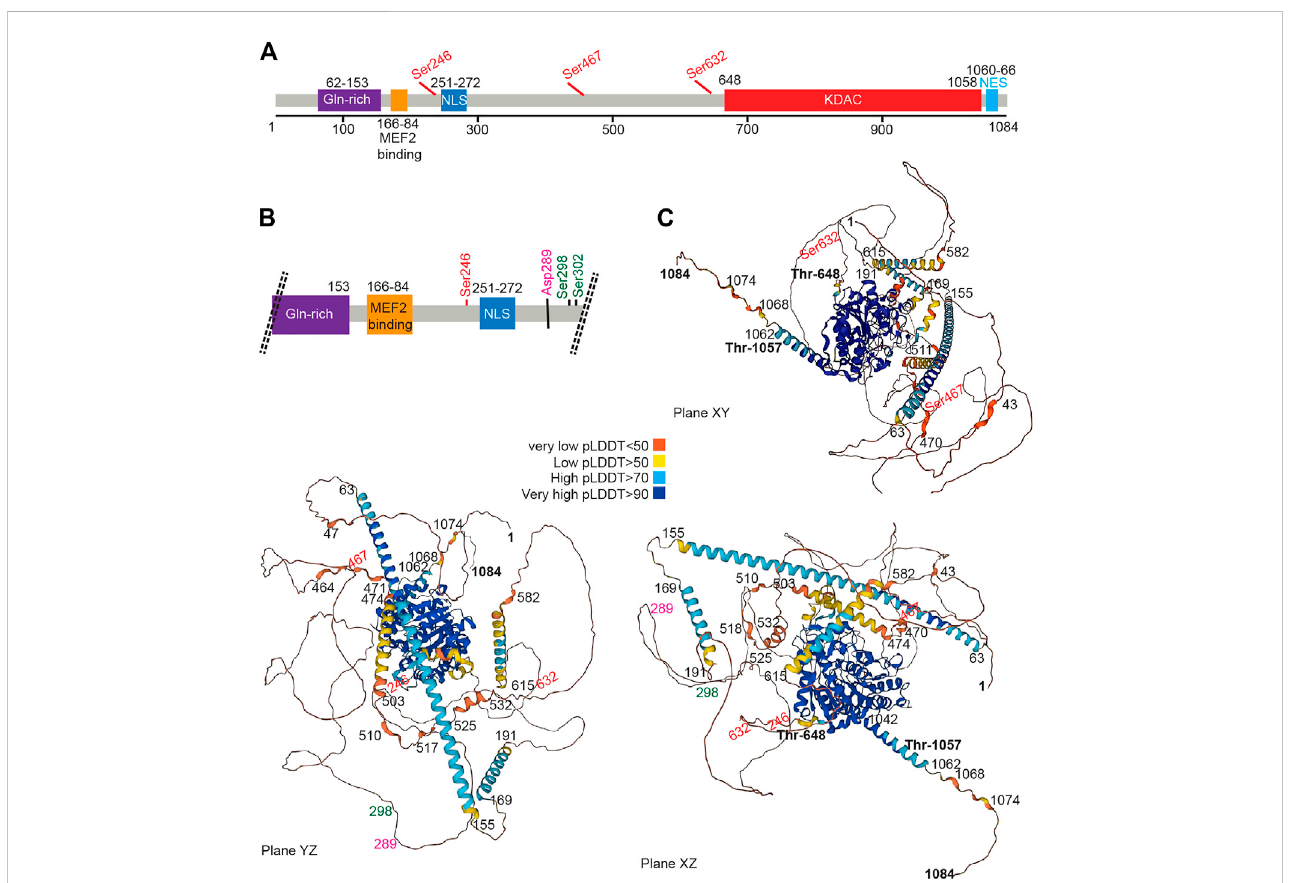
FIGURE 2 The HDAC4 protein. (A) Schematic view of the HDAC4 protein. The major domain and regulative aa sites are highlighted. (B) Schematic view at higher magni fi cation of the N-terminal region of HDAC4. (C) AlphaFold prediction of HDAC4 structure. Three different views are provided. Colors indicate the different per-residue con fi dence score (pLDDT) as indicated. Some regions below 50 pLDDT may be unstructured in isolation. https://alphafold.ebi.ac.uk/